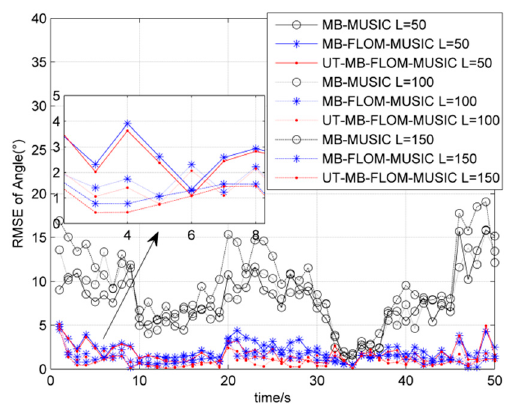
Figure 7. RMSE for source tracking under different snapshots, α = 1.3 MC = 100 and GSNR = 10 dB.